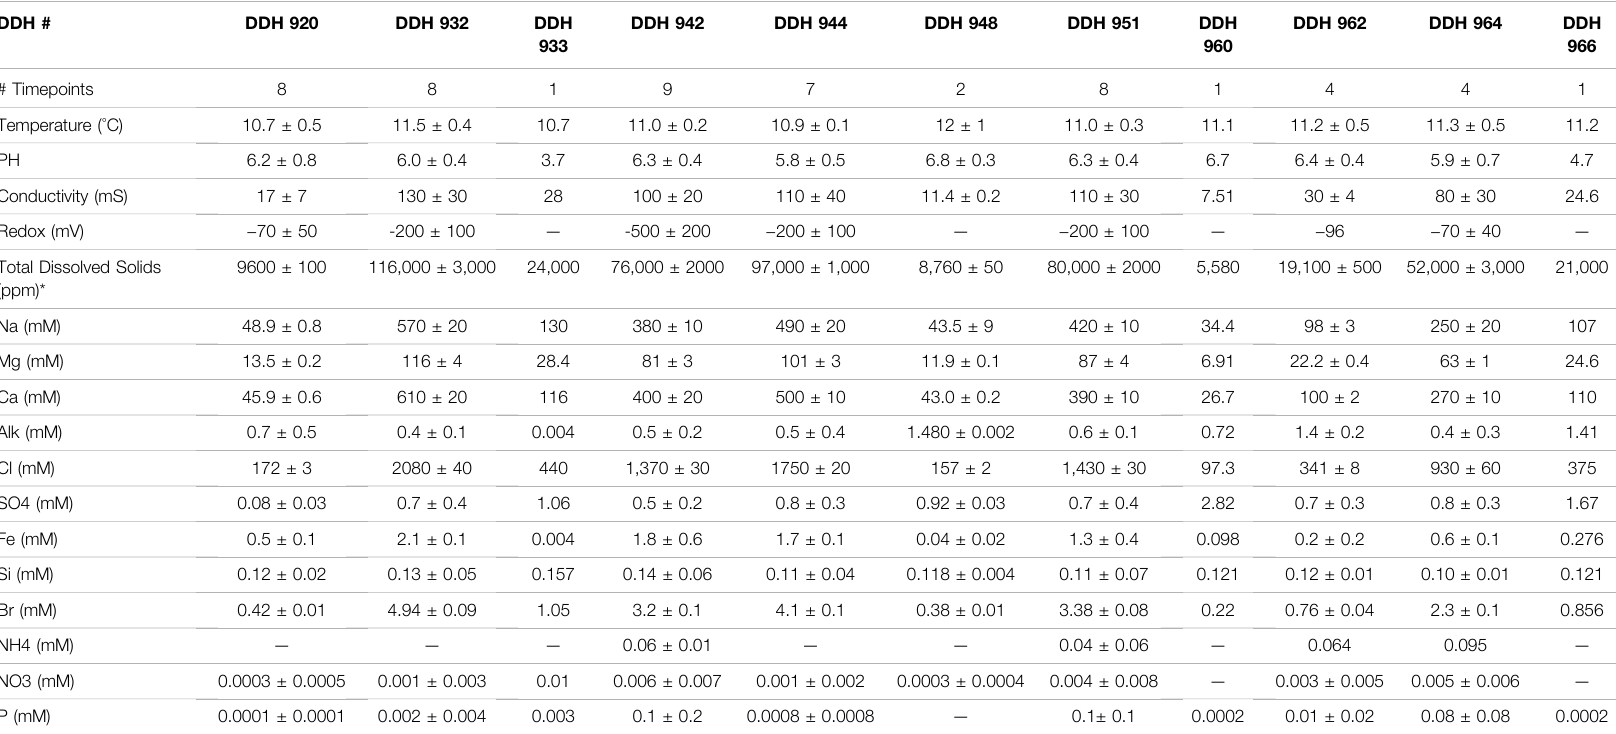
TABLE 2 | Chemical characteristics of